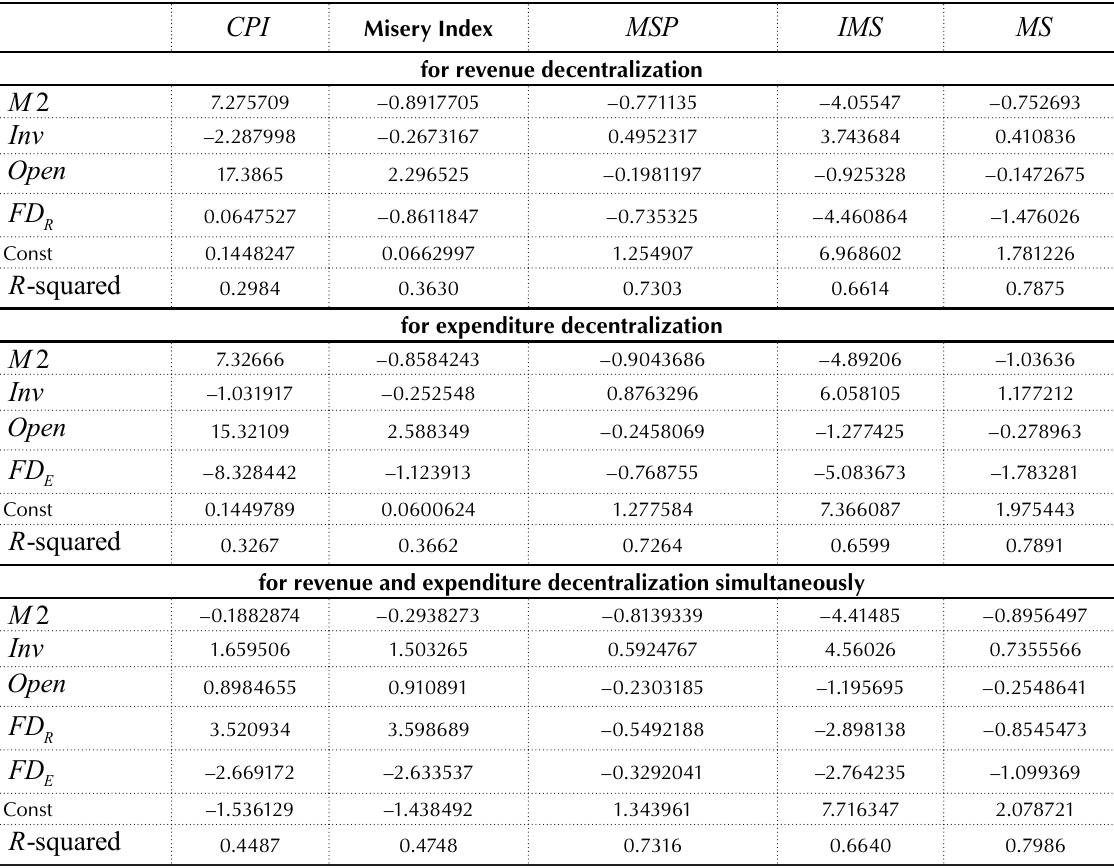
Table 4. Results of impact assessment of fiscal decentralization on macroeconomic stability of Ukraine for the period 2000–2015 (based on our own